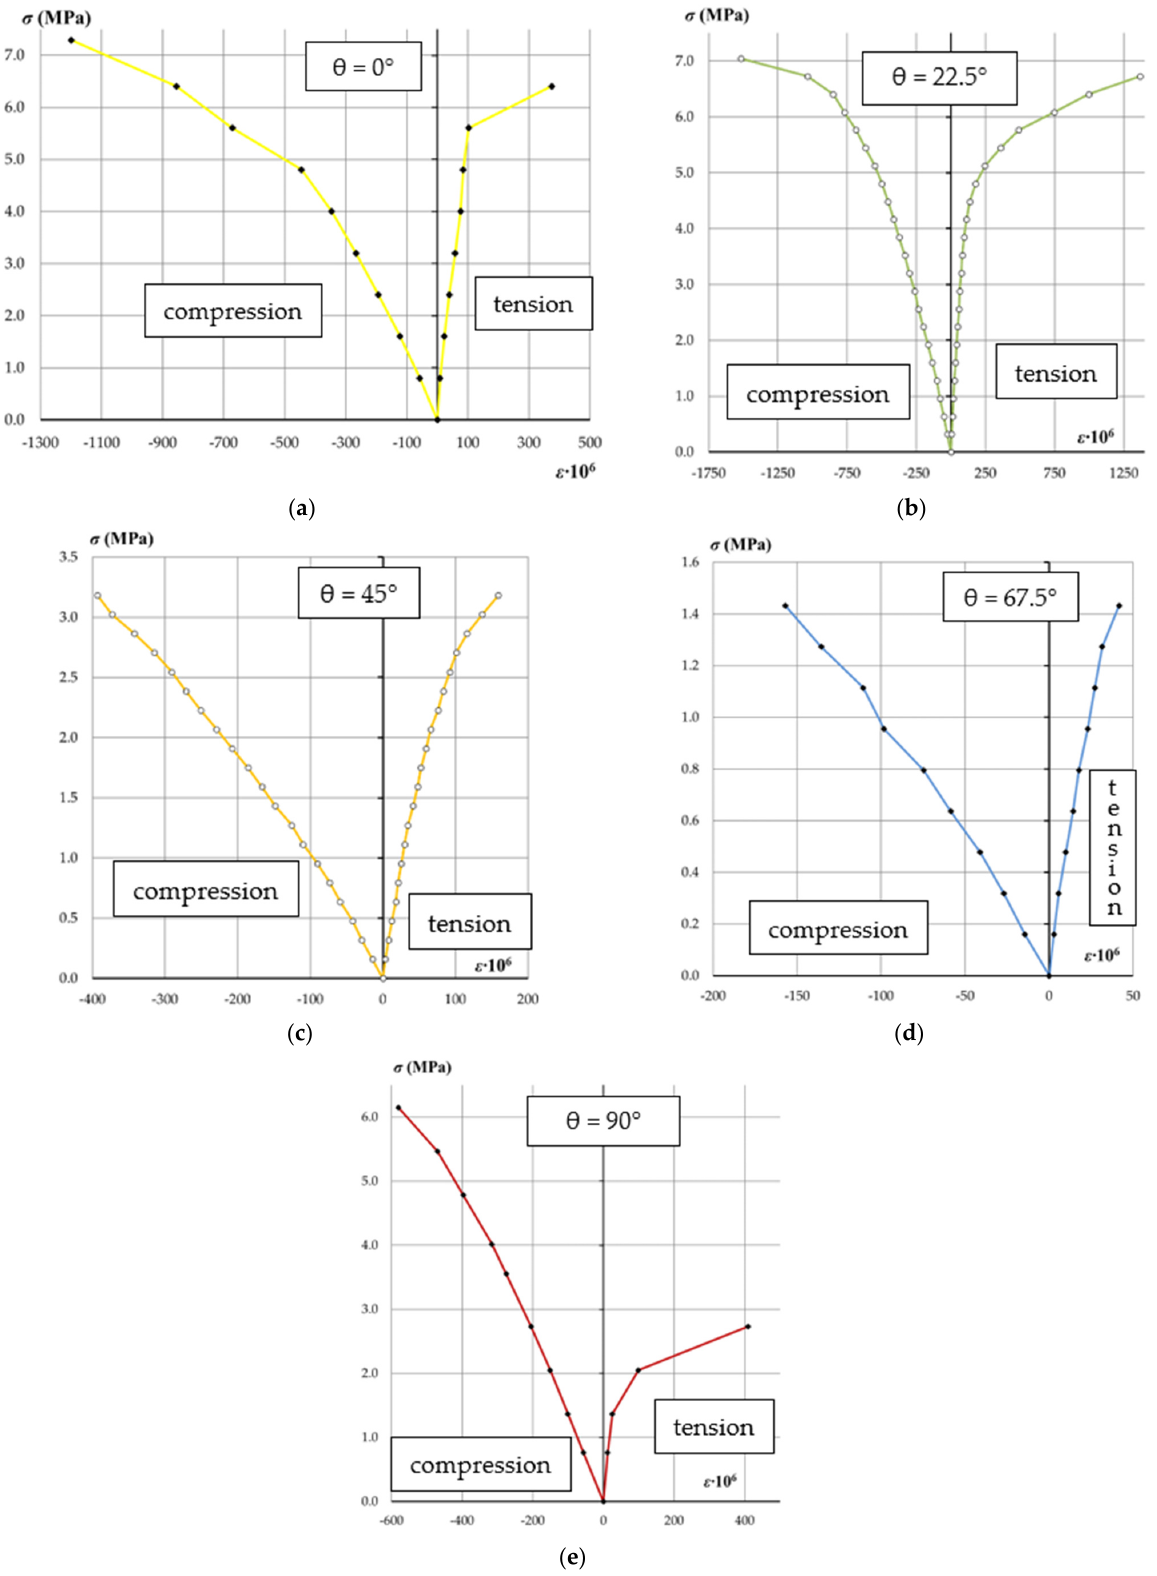
Figure 8. Stress–strain diagrams for compressed wall samples at different joint angles ( a ) θ = 0°, ( b ) θ = 22.5°, ( c ) θ = 45°, ( d ) θ = 67.5°, ( e ) θ = 90°.